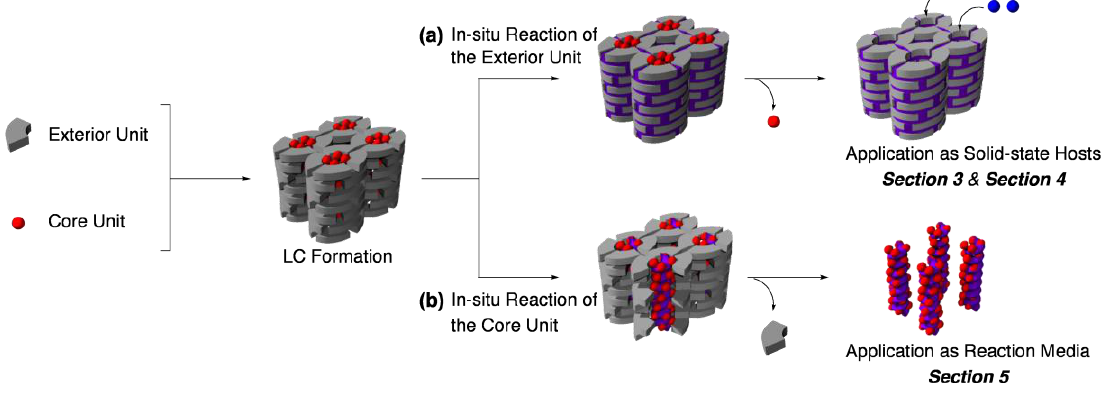
Figure 1. In situ reactions of two-component LCs at ( a ) exterior and ( b ) core